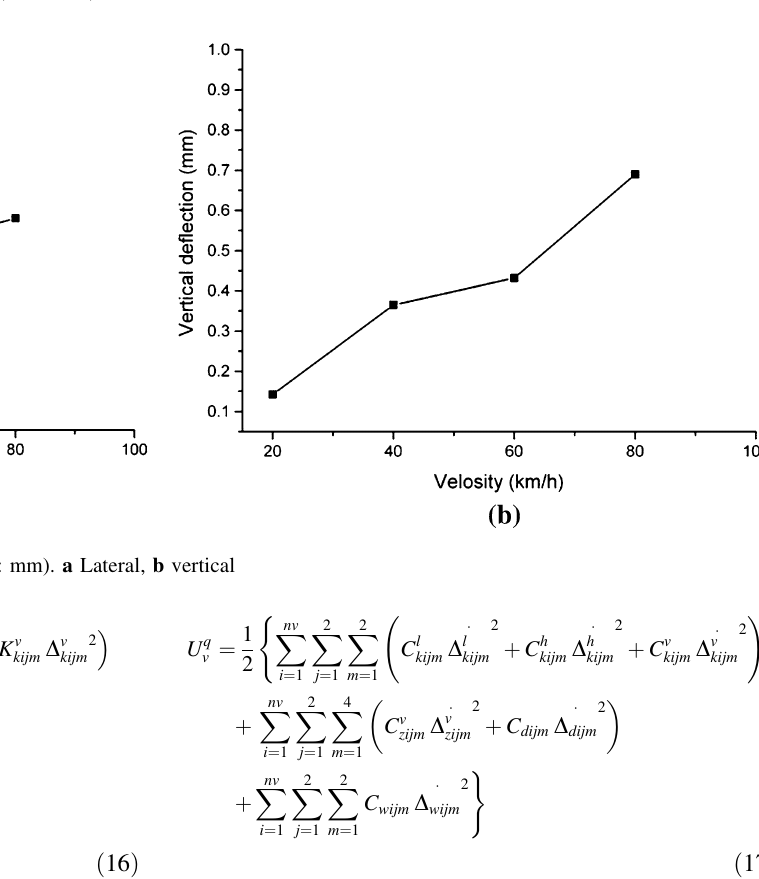
Fig. 8 Observations of acceleration at middle span (unit: m/s 2 ). a Lateral, b vertical